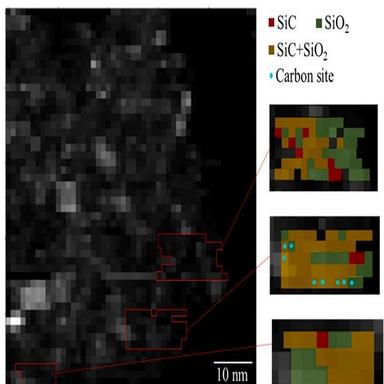
Crystallinity mapping of the SiOC material pyrolyzed at 1400 ◦C with the presence of specific phases (red-SiC, green-SiO2, cyan-graphite, and yellow-SiC plus SiO2). (For interpretation of the references to colour in this figure legend, the reader is referred to the web version of this article.)